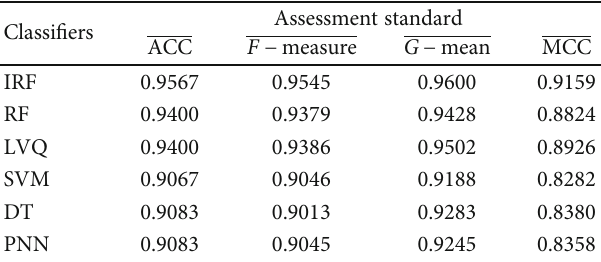
Table 5: Comparison of di ff erent classi fi er